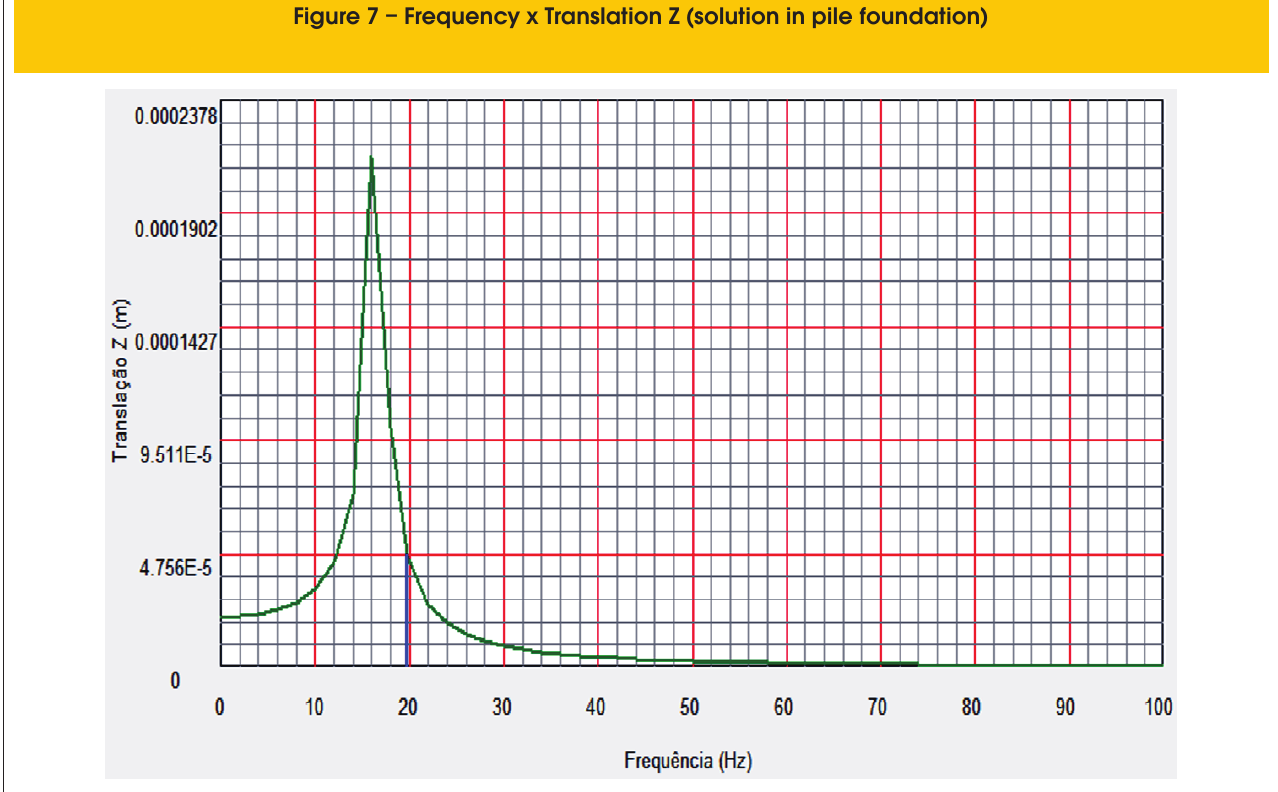
Figure 7 – Frequency x Translation Z (solution in pile